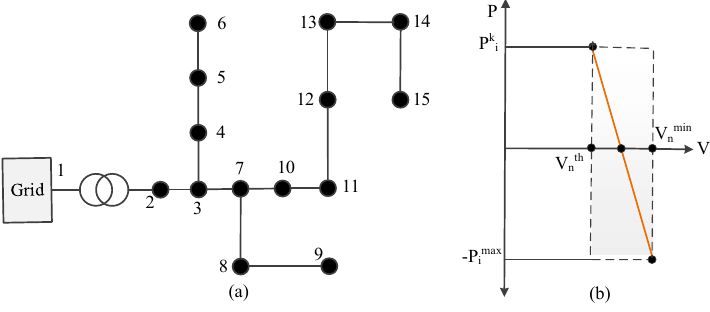
Figure 7. ( a ) Test case network; and ( b ) adaptive P ( V ) droop.